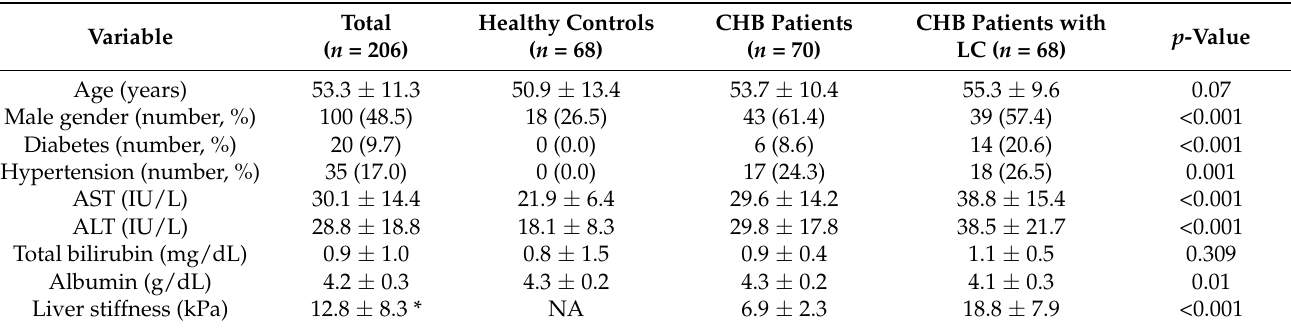
Figure 1. The diagram of patient disposition. CHB, chronic hepatitis B; LC, liver cirrhosis. Table 1. Baseline characteristics of study participants.